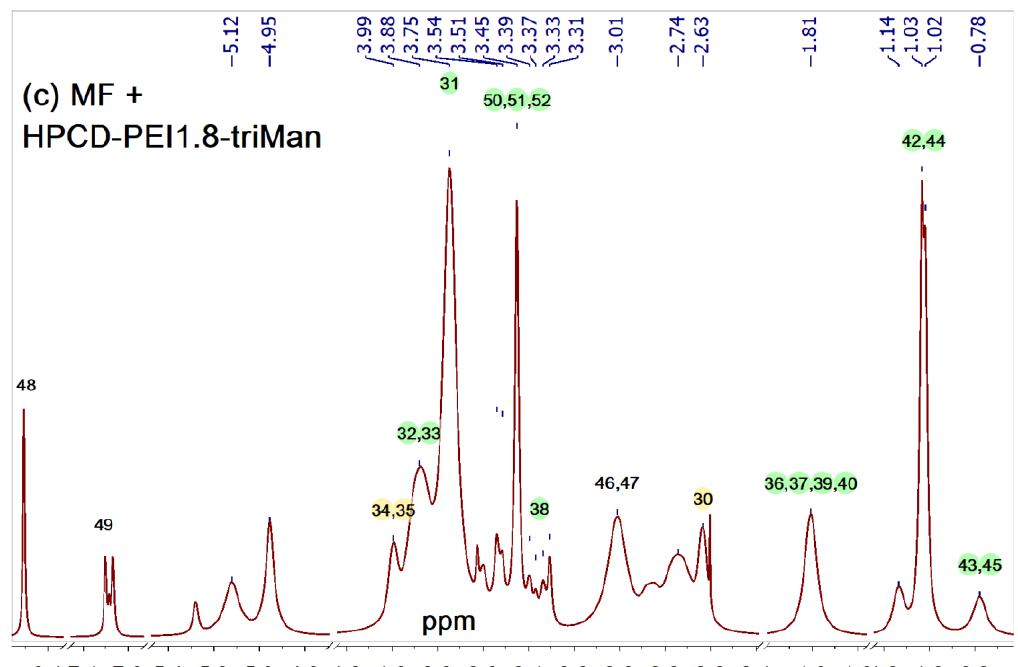
Figure 6. 1 H NMR spectra of ( a ) MF, ( b ) MF complexed with PEI1.8-triMan (w:w = 1:1), and ( c ) MF complexed with HPCD-PEI1.8-triMan (w:w = 1:1) with proton assignment. D 2 O, 400 MHz. Table 4. 1 H-chemical shifts corresponding to MF in free form and in the form of non-covalent com- plexes with ligands 2a and 2b (PEI1.8-triMan and HPCD-PEI1.8-triMan). D 2 O, 400 MHz.